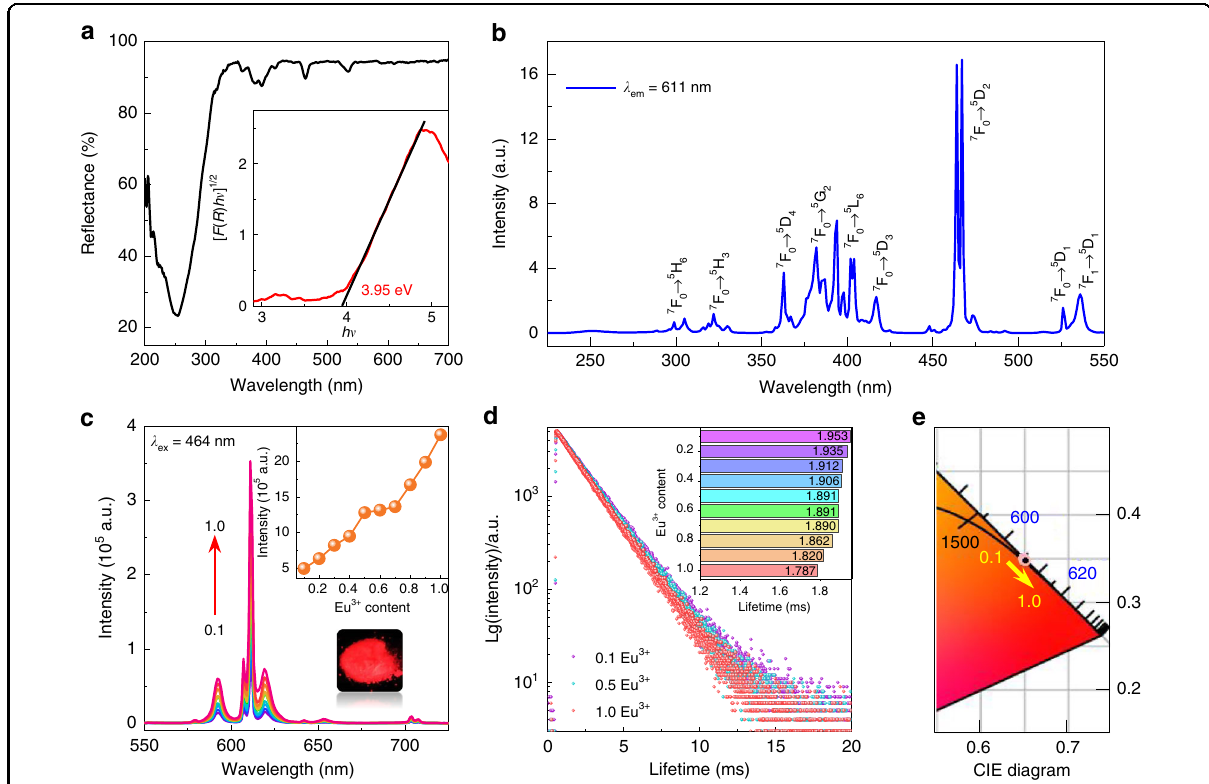
Fig. 2 Photoluminescence properties. a Diffuse re fl ection spectrum of CEGO. The inset depicts the relationship of [ F ( R ) hv ] 1/2 versus hv . b PLE spectrum of CEGO monitored at a 611 nm emission wavelength. c PL spectra of CGGO: x Eu 3 + ( x = 0.1 – 1.0) samples excited at 464 nm blue light. The inset shows the PL intensity of CGGO: x Eu 3 + ( x = 0.1 – 1.0) samples. d PL decay curves of the CGGO: x Eu 3 + ( x = 0.1 – 1.0) samples excited at 464 nm and monitored at 611 nm wavelength. e CIE chromaticity coordinate diagram of the CGGO: x Eu 3 + ( x = 0.1 – 1.0)